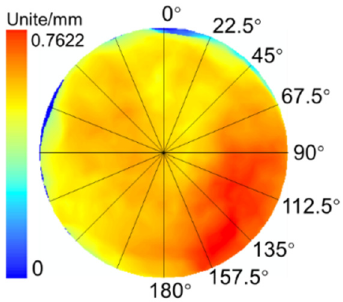
Figure 12. Digital elevation information map of the upper surface of core disc no. 3-1.